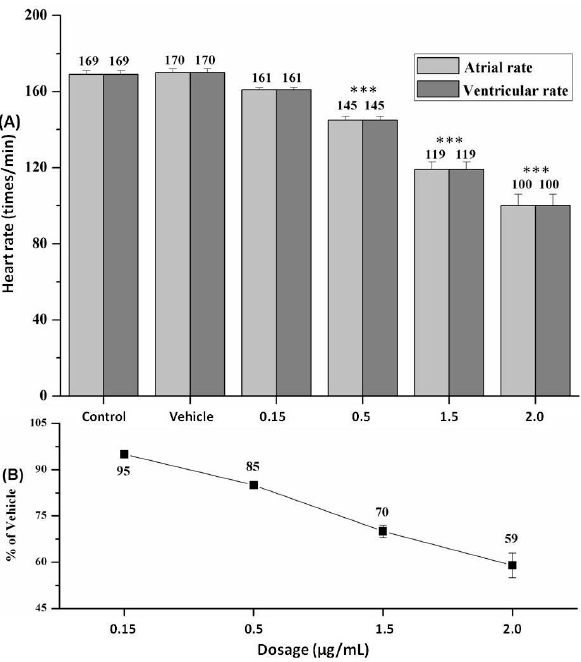
Figure 3. Zebrafish heart rate changes. ( A ) Heart rate (times/minute); ( B ) relative heart rate (%) of SA ‐ treated zebrafish. All data are represented as the mean ± standard deviation (SD). *** p < 0.001 vs. vehicle control.